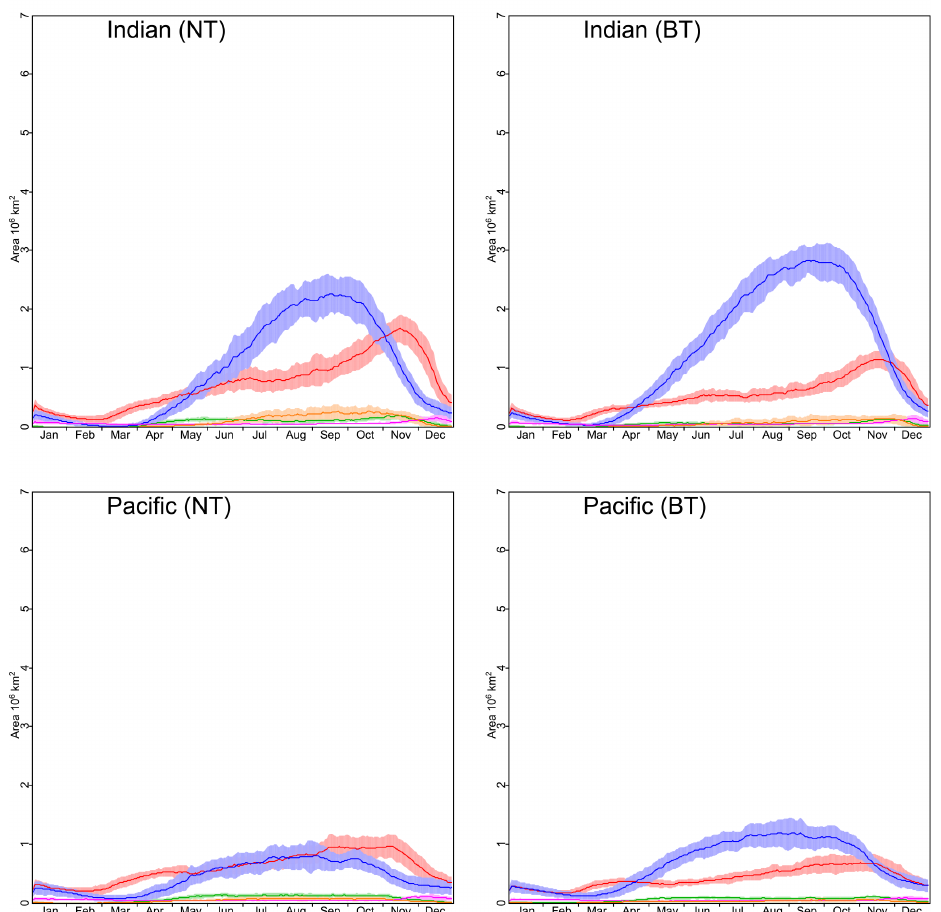
Figure 6. Long-term (1979–2013) seasonal cycle in regional sea ice extent of the consolidated pack ice, the outer marginal ice zone, polynyas, open pack ice (or broken ice within the pack ice), and inner open water. Results for the NASA Team algorithm are shown on the left and Bootstrap on the right for the Ross Sea, Bellingshausen–Amundsen Sea, Weddell Sea, Indian Ocean and Pacific